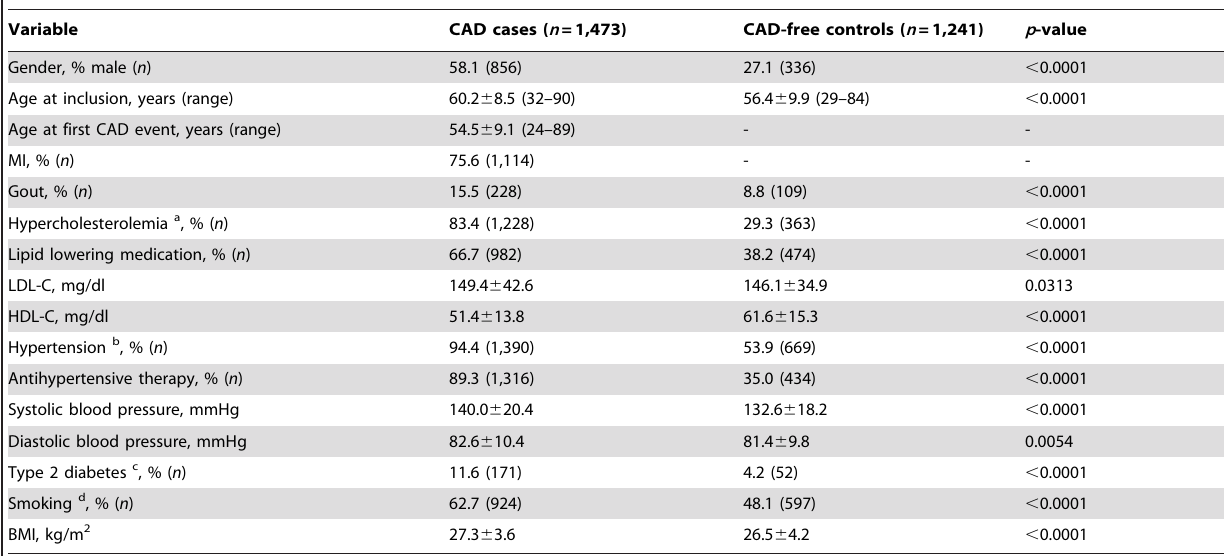
Table 2. Characteristics of CAD case and control study sample.